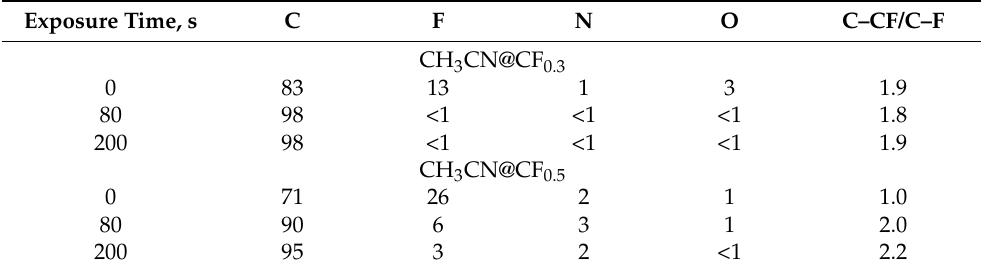
Table 1. XPS determined content (at%) of main elements in CH 3 CN@CF 0.3 and CH 3 CN@CF 0.5 samples before and after exposure to polychromatic synchrotron light for 80 and 200 s. The ratio of the areas of the C–CF to C–F components in the XPS C 1s spectra (last column). Exposure Time,